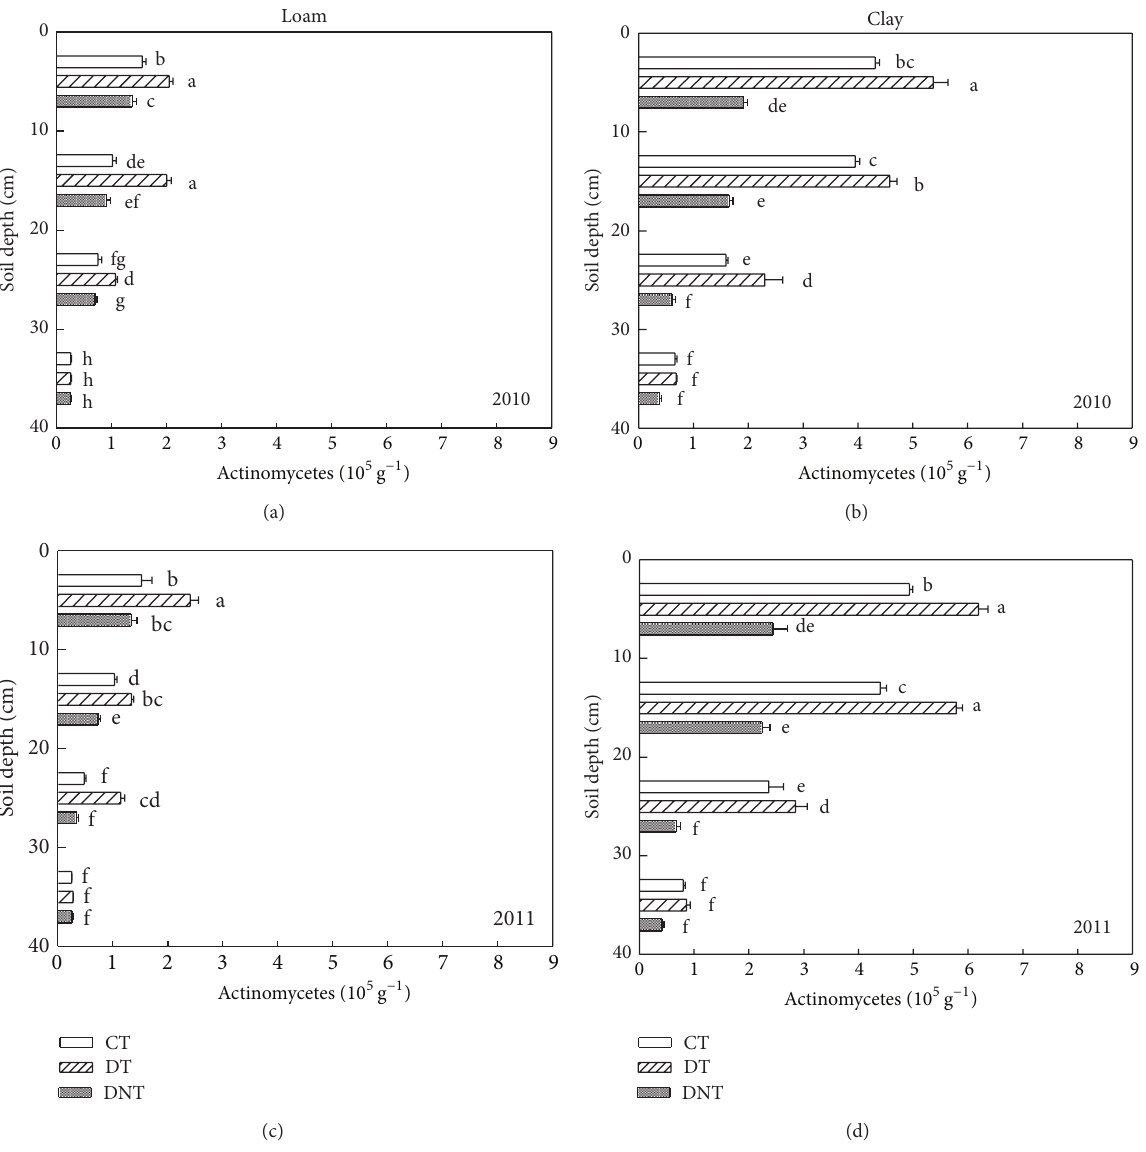
Figure 1: Effects of tillage and straw returning on the number of soil actinomycetes. Different small letters indicated significant difference at 𝑃 < 0.05 according to Duncan’s test. CT represented conventional tillage, moldboard ploughed to a depth of 20 cm, and straw was returned. DT represented deep tillage moldboard ploughed to a depth of 30 cm and straw was returned. DNT represented deep tillage moldboard ploughed to a depth of 30 cm and straw was